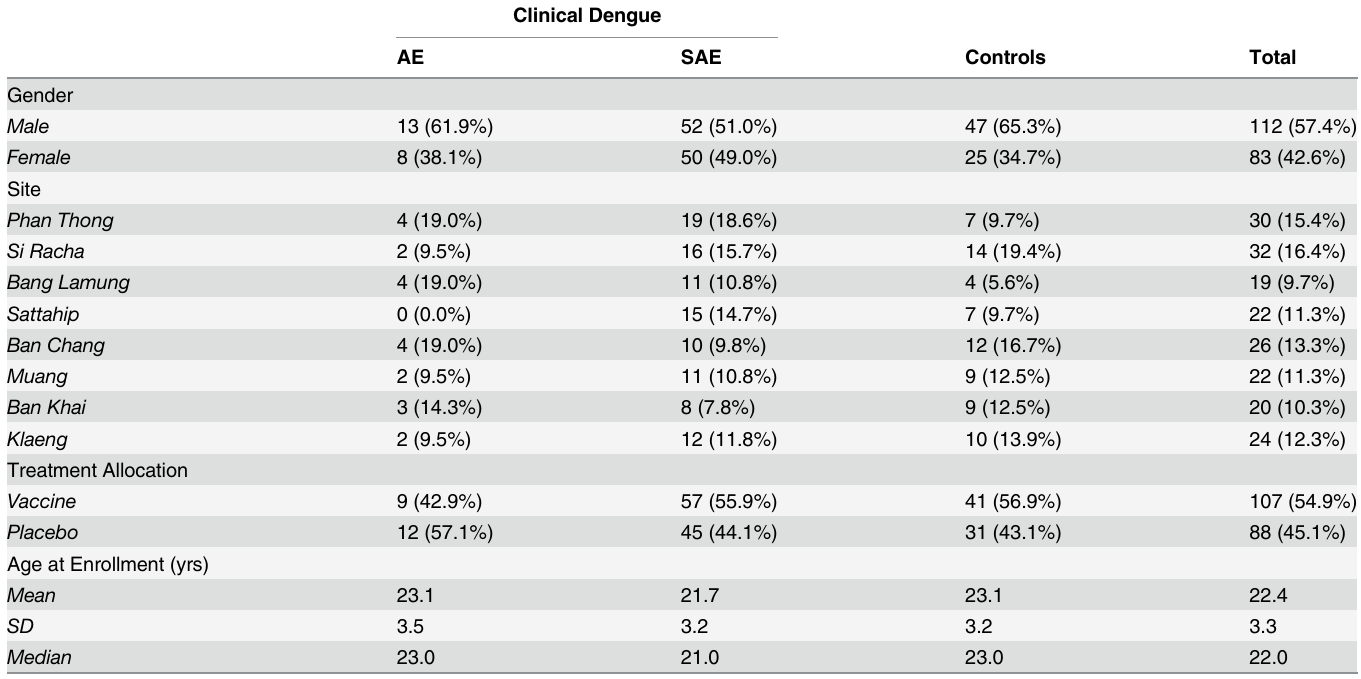
Table 1. Demographic Characteristics of RV144 Participants with Clinical Dengue Episodes and Non-Dengue Serious Adverse Events (Controls).